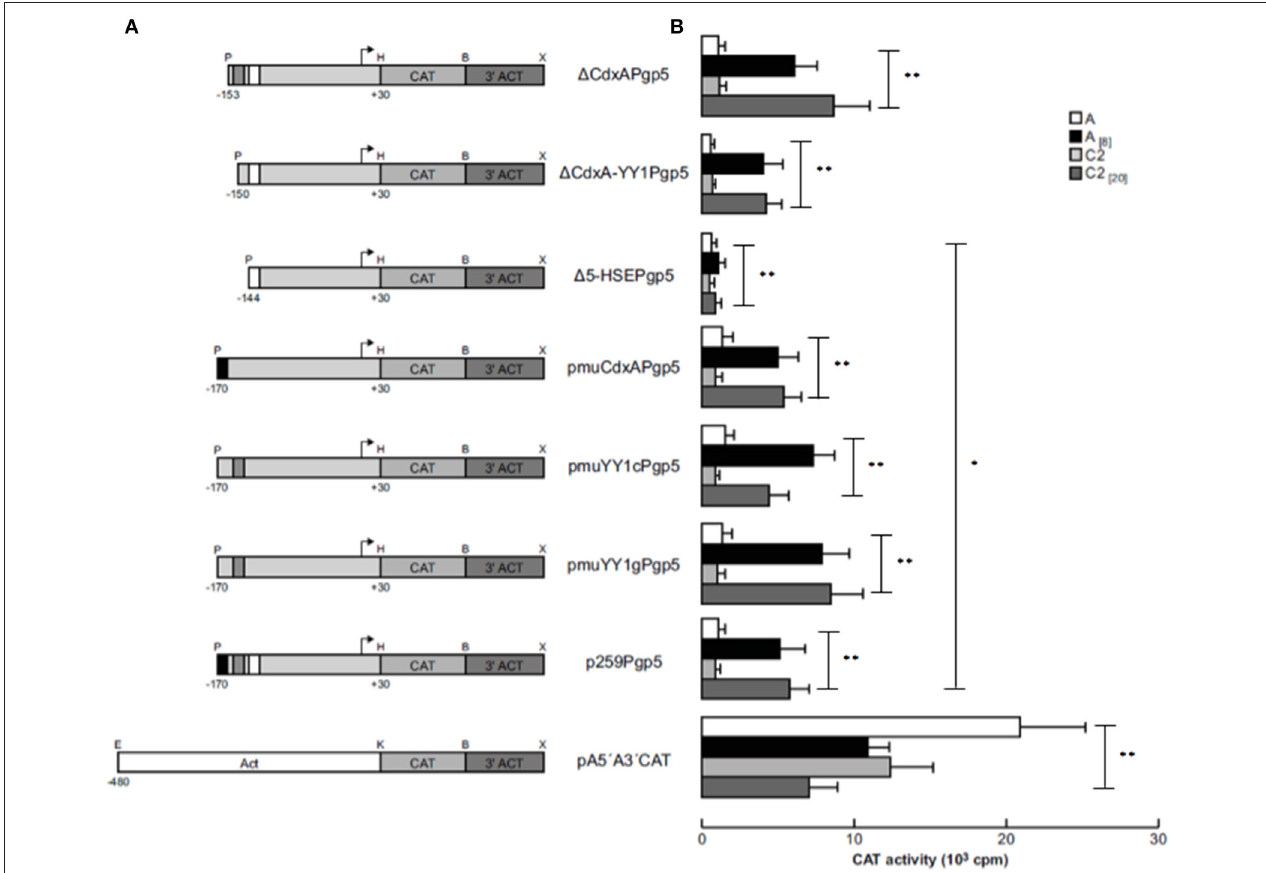
FIGURE 2 | Functional identification of the ERE in the region from − 170 to − 111 bp of the EhPgp5 gene core promoter. (A) Schematic representation of the constructs used for the transfection assays. All of the plasmids contain the CAT reporter gene and the 3 ′ -flanking actin region (3 ′ ACT). Arrows, transcription initiation sites. P, Pst I; H, Hind III; B, Bam HI; X, Xho I; E, EcoR I; K, Kpn I. CdxA, YY1, and HSE motifs are in black, gray and white boxes, respectively. (B) Bars show the average of CAT activity (cpm) of the transfected plasmids obtained by the two-phase diffusion assays ± SD, representative of three independent experiments performed